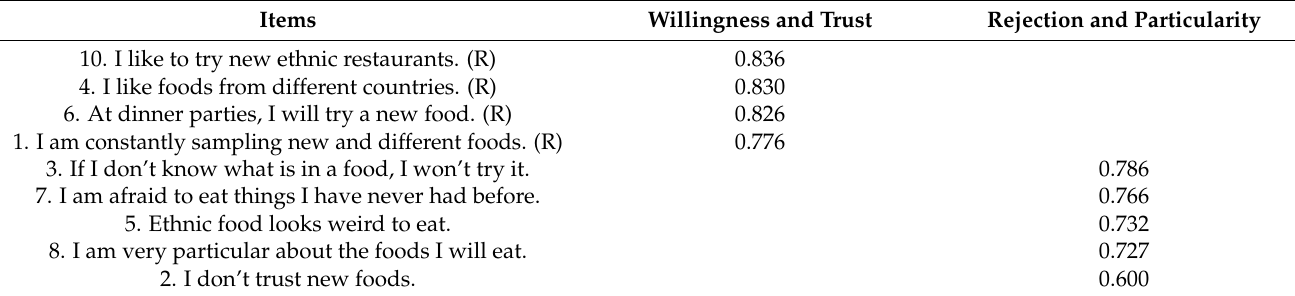
Table 4. Results of the exploratory factor analysis on the